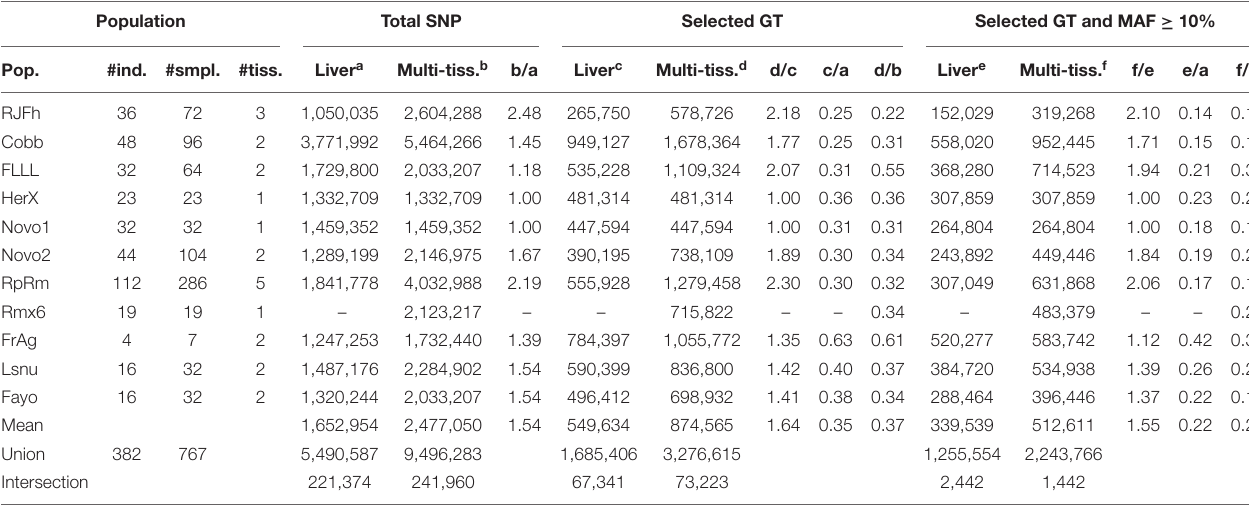
TABLE 1 | SNP counts per population retained at each step of the selection. Population Total SNP Selected GT Selected GT and MAF ≥ 10% Pop. #ind. #smpl. #tiss.